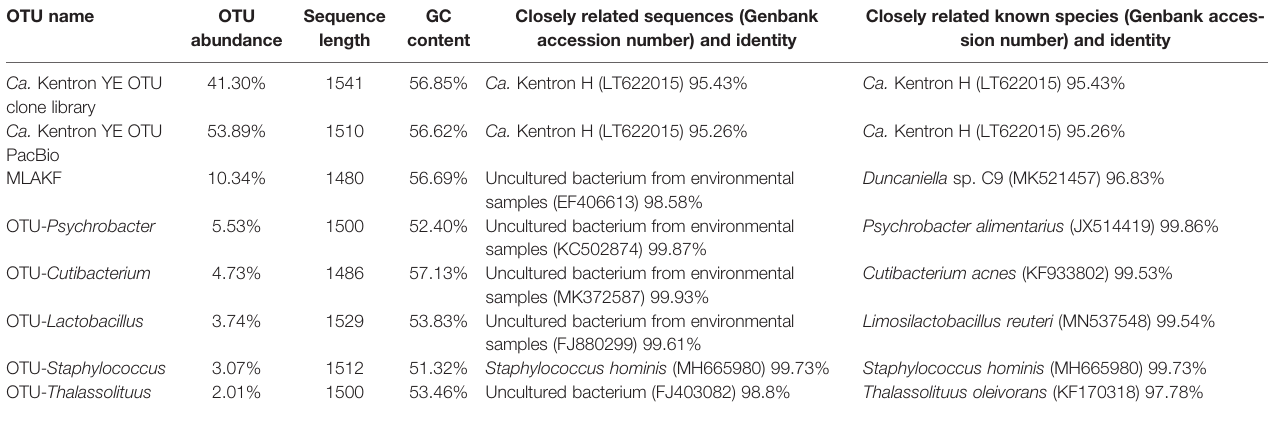
TABLE 2 | Details of 16S rRNA gene fragments of “ Ca . Kentron ” YE and the measurable bacterial OTUs revealed by PacBio